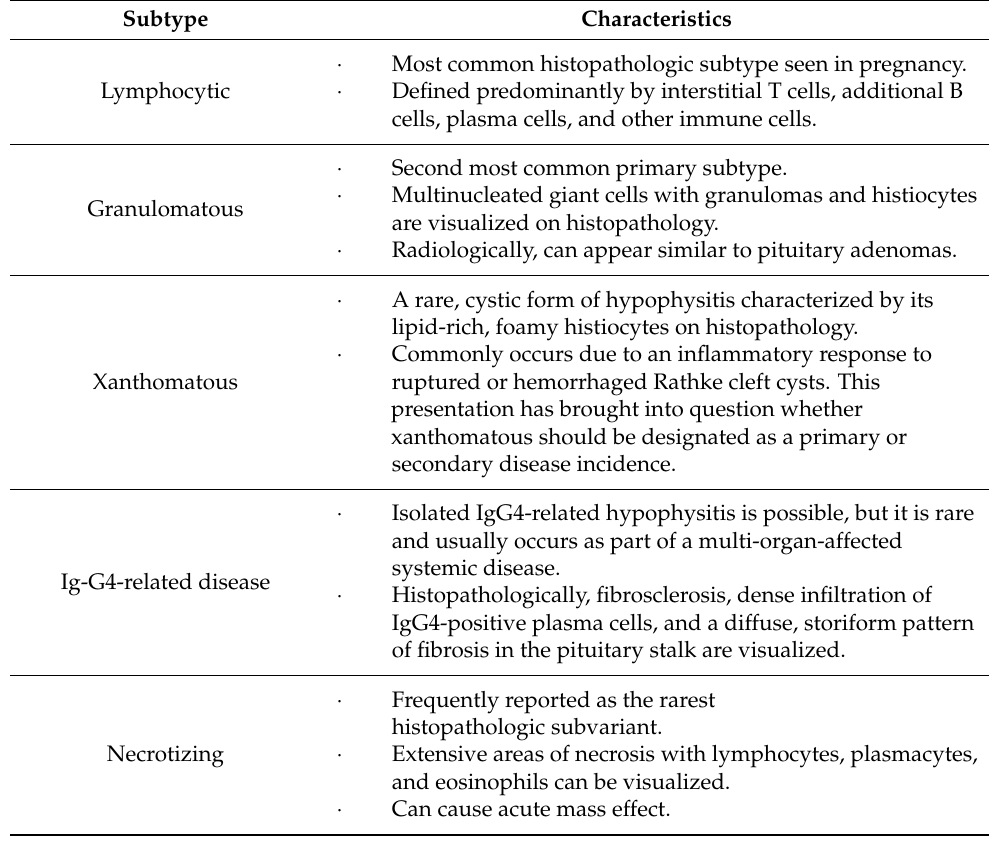
Table 1. Primary histopathologic subtypes of